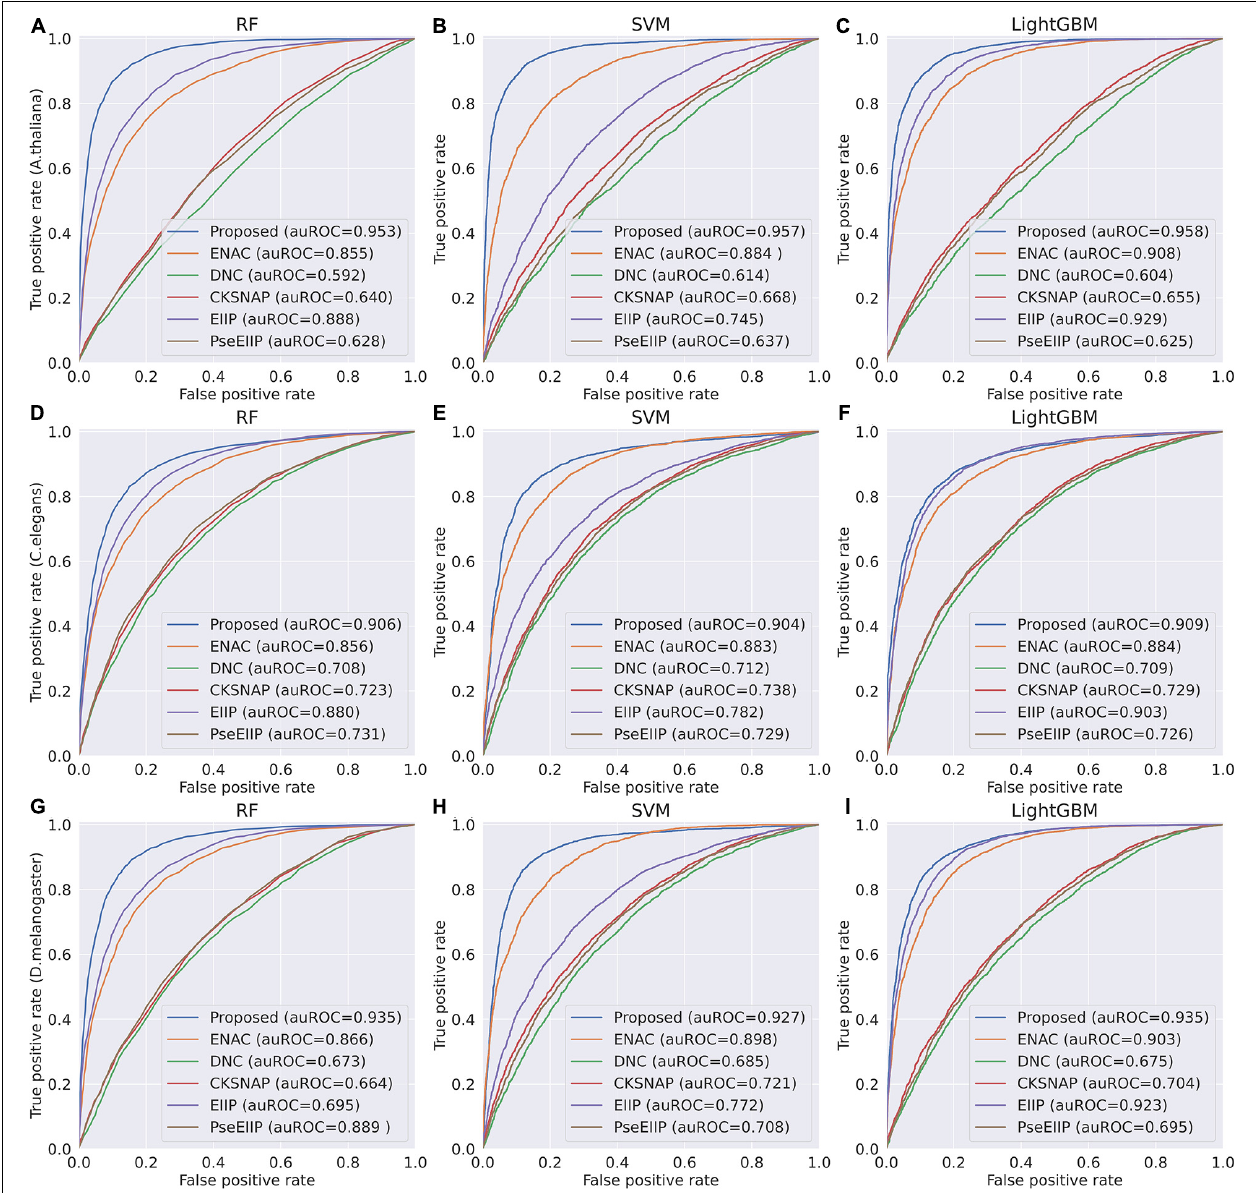
FIGURE 4 | ROC curves of the Proposed, ENAC, DNC, CKSNAP, EIIP, and PreEIIP methods are based on the three basic classifiers for each species. (A–C) The results of the species A. thaliana . (D–F) The results of the species C. elegans . (G–I) The results of the species D. melanogaster.